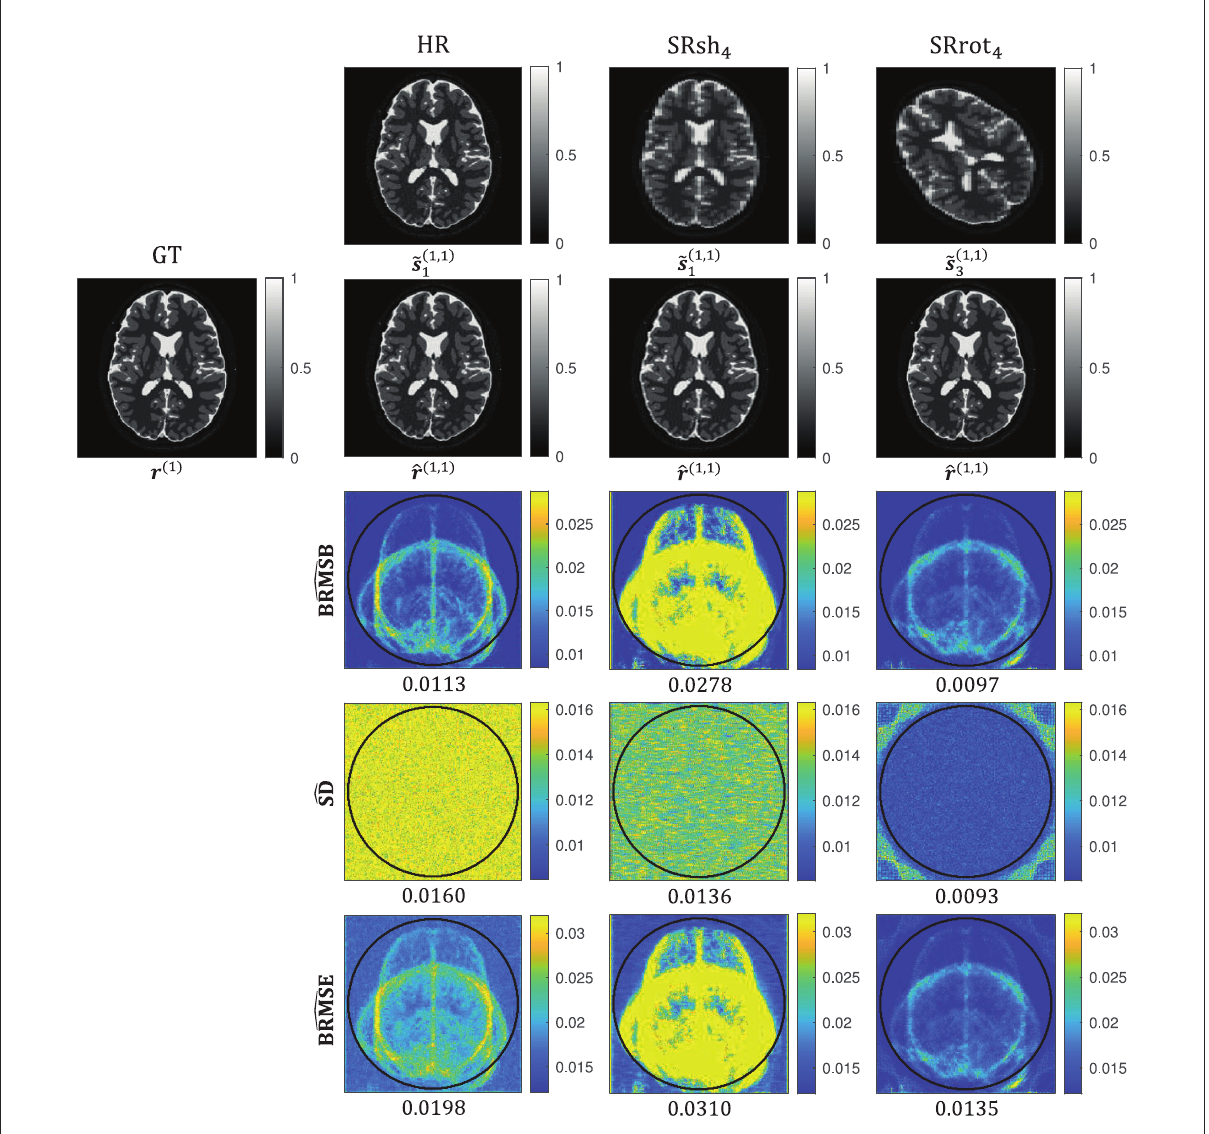
FIGURE5 Monte Carlo simulation results for the protocols HR, SRrot 4 , and SRsh 4 . In the first two rows, r ( n v ) , ˜ s ( n e , n v ) n , and from the validation dataset, the n -th noise-corrupted MS image simulated using the n v -th image from the validation dataset as ground truth in the n e -th repetition of the experiment, and the MS-SRR image estimated from ˜ s ( n e , n v ) , respectively. In the last three rows, the Monte Carlo estimates \ BRMSB, SD, and \ BRMSE are shown. For each map, the median value computed inside an ROI is reported. The ROI was defined as the part of the field of view common to all the acquired images of all the acquisition protocols, which corresponds with the area inside the circle c plotted in the